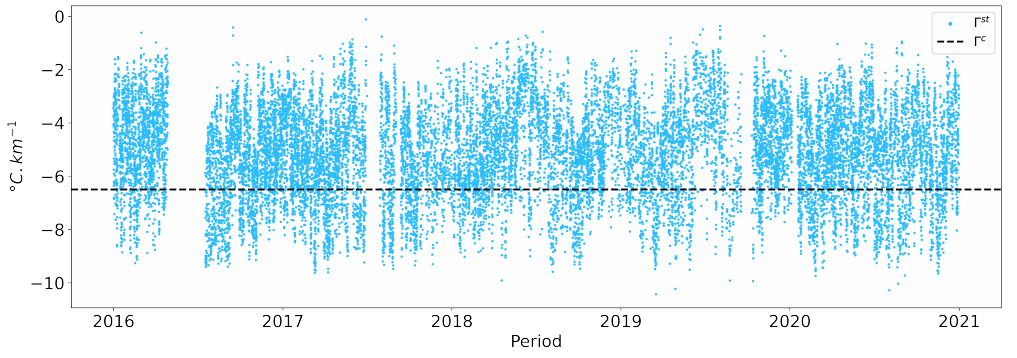
Figure 3. Pronounced ELR’s hourly temporal variability, measured using AWS records over the period of interest (from 1 January 2016 to 31 December